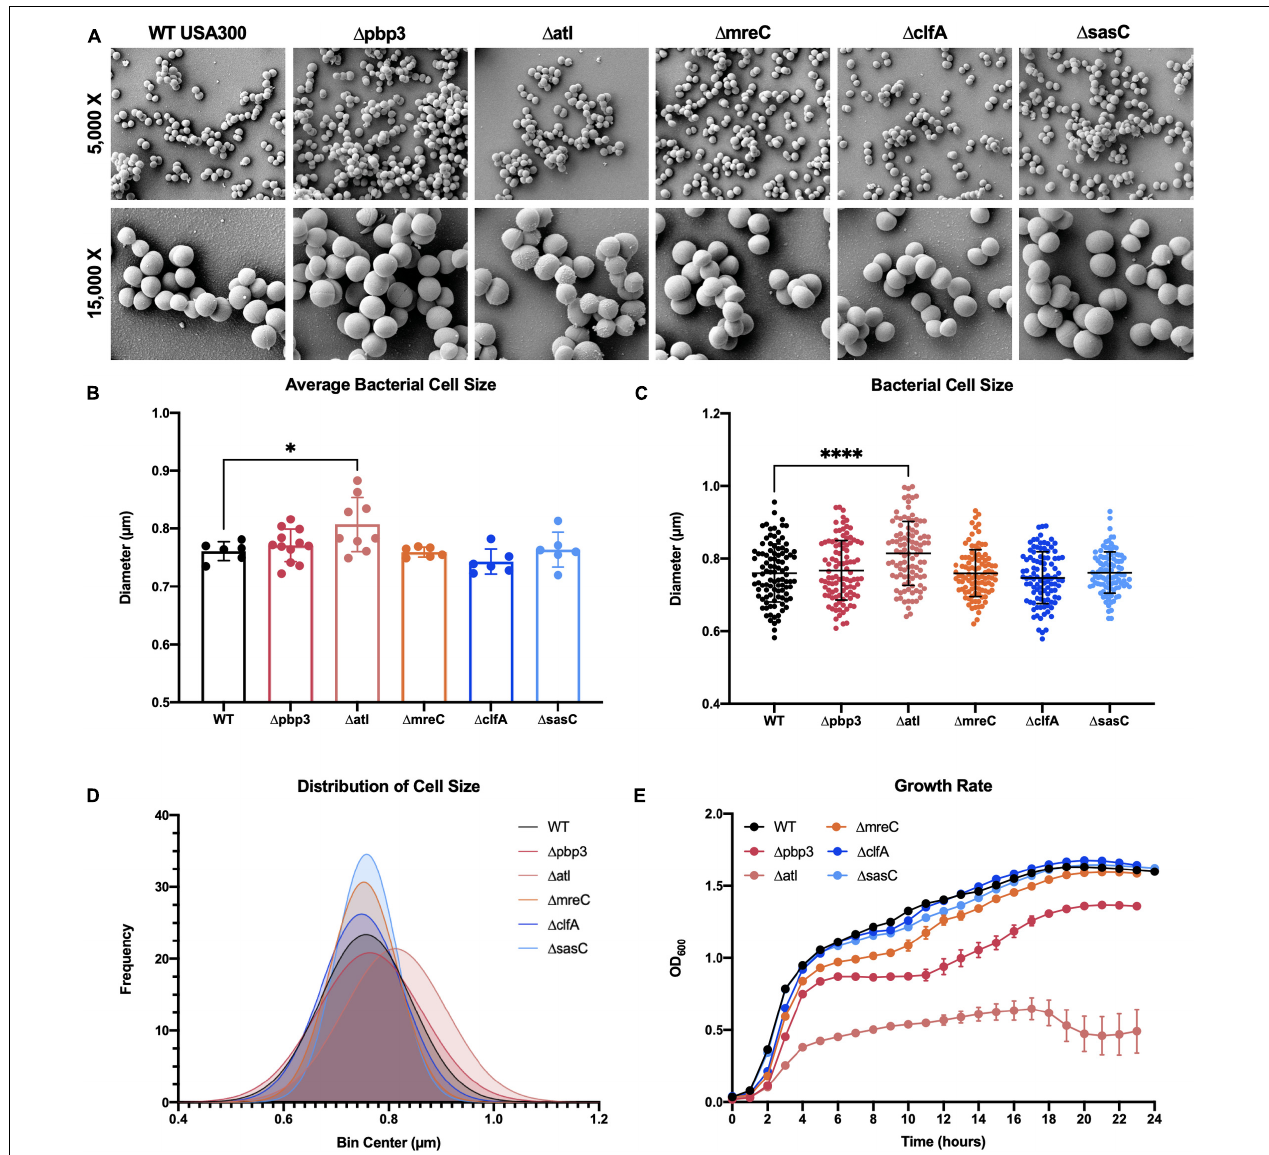
FIGURE 2 | Staphylococcus aureus deletion mutant cell morphology and growth rate characterization. Cultures of WT USA300 and (cid:49) pbp3, (cid:49) atl, (cid:49) mreC, (cid:49) clfA, and (cid:49) sasC were grown on glass coverslips and processed for scanning electron microscopy (SEM; n = 3 independent replicates). Representative images are shown to illustrate the absence of gross morphological differences in all mutant stains besides the (cid:49) atl mutant strain (A) . The (cid:49) atl mutant shows characteristic “rough” cell wall, particularly in regions of older peptidoglycan (magnified in Figure 3 ). Bacterial cell size was quantified as the maximum cell diameter from at least six SEM images ( B ; average size per image, n > 6) and the data for each bacterium with mean and SD presented ( C ; by one-way ANOVA with Dunnett’s post-hoc test for multiple comparisons vs. WT, n = 100). A Gaussian curve was fit to a histogram of cell sizes to visualize the distribution of cell diameters for each genotype (D) . WT and deletion mutants were grown in liquid culture and measured by optical density at 600 nm hourly for 24 h. The (cid:49) pbp3 mutant showed significantly reduced growth during stationary phase, and (cid:49) atl showed extremely hindered growth through all phases (E) . Growth rate was evaluated by via two-way ANOVA with Dunnett’s post-hoc for multiple comparisons vs. WT ( n = 3, data presented as mean ± SEM). Strains (cid:49) atl and (cid:49) pbp3 were significantly different from WT at time points 3–23 and 8–23 h, respectively ( p < 0.05).